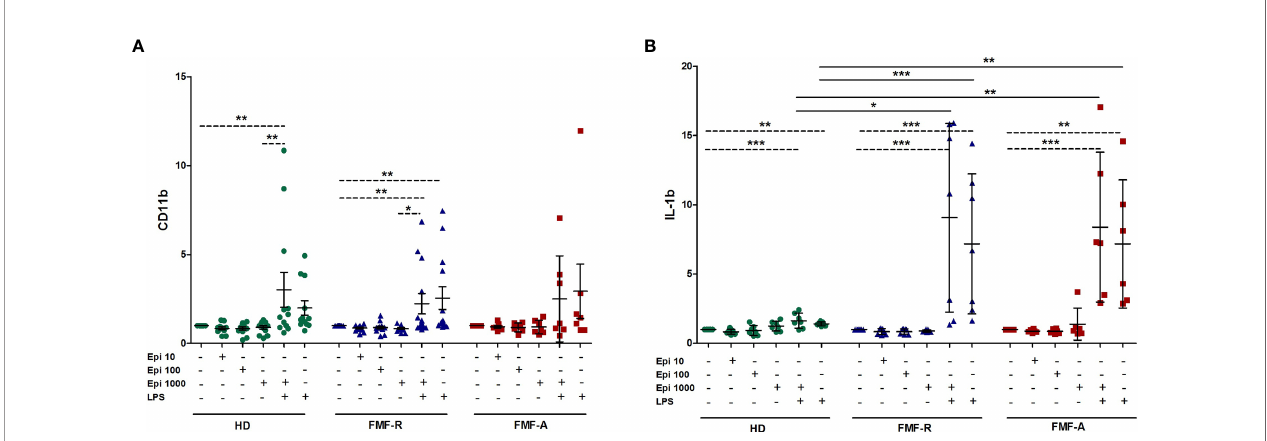
FIGURE 7 | Effect of stress-related hormone Epinephrine (Epi) on PMNs activation. Whole blood cells were cultured in the absence or presence of Epi (10, 100, 1000 m M), LPS (100 ng/ml) or LPS (100 ng/ml) + Epi (1000 m M) for 4h. (A) Surface expression of CD11b (MFI) analysed by fl ow cytometry; (B) IL-1 b production by whole blood cells was assessed in culture supernatants using ELISA. Data presented as fold change for stimulated CD11b and IL-1 b production versus unstimulated ones. * p < 0.05; ** p < 0.01; *** p <